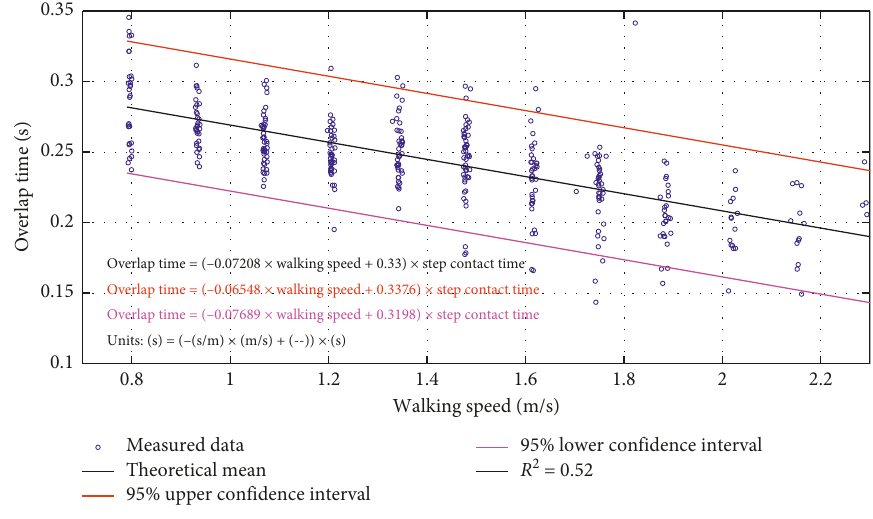
Figure 11: Overlap time